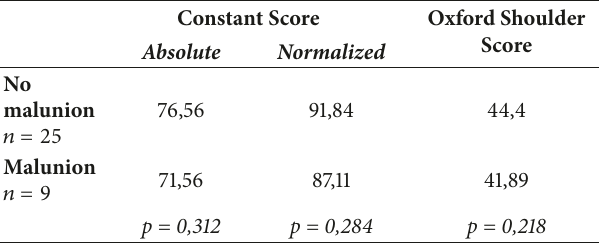
Table 4: Correlation between clinical scores and